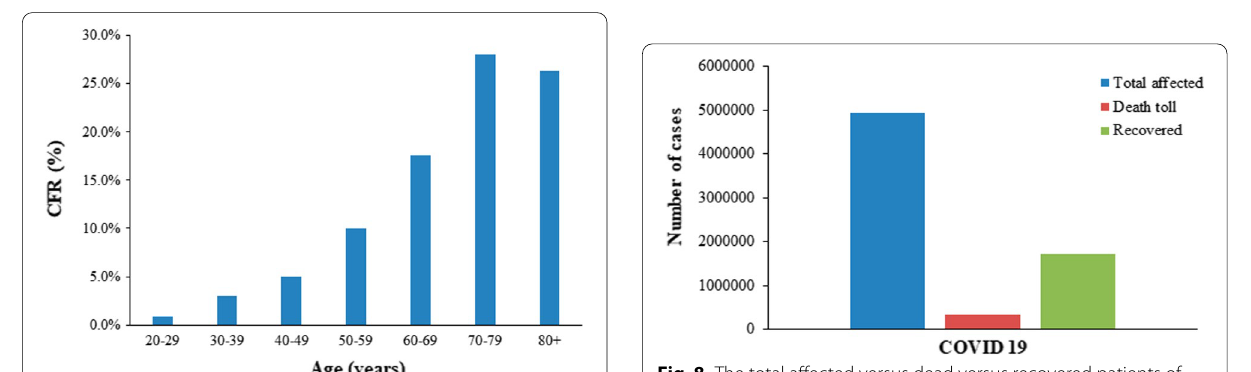
Fig. 8 The total affected versus dead versus recovered patients of COVID-19 (as of 20th May